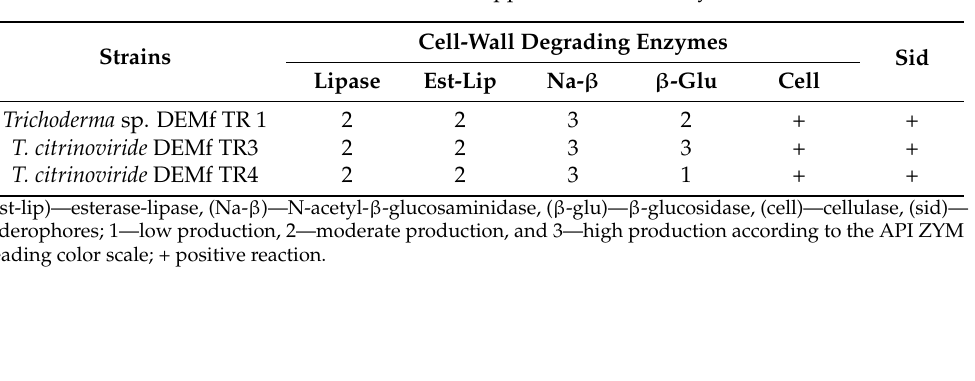
Table 3. Biochemical characteristics of Trichoderma spp. used in this